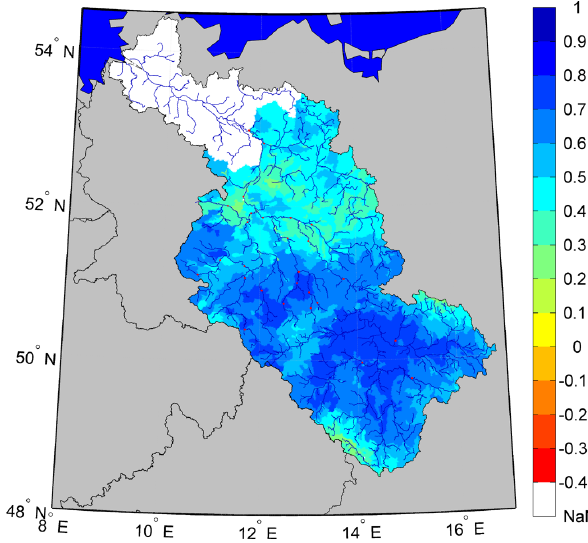
Fig. 3. Pearson correlation coefficient (significant level 5%) be- tween the median simulated SMI and the remotely sensed